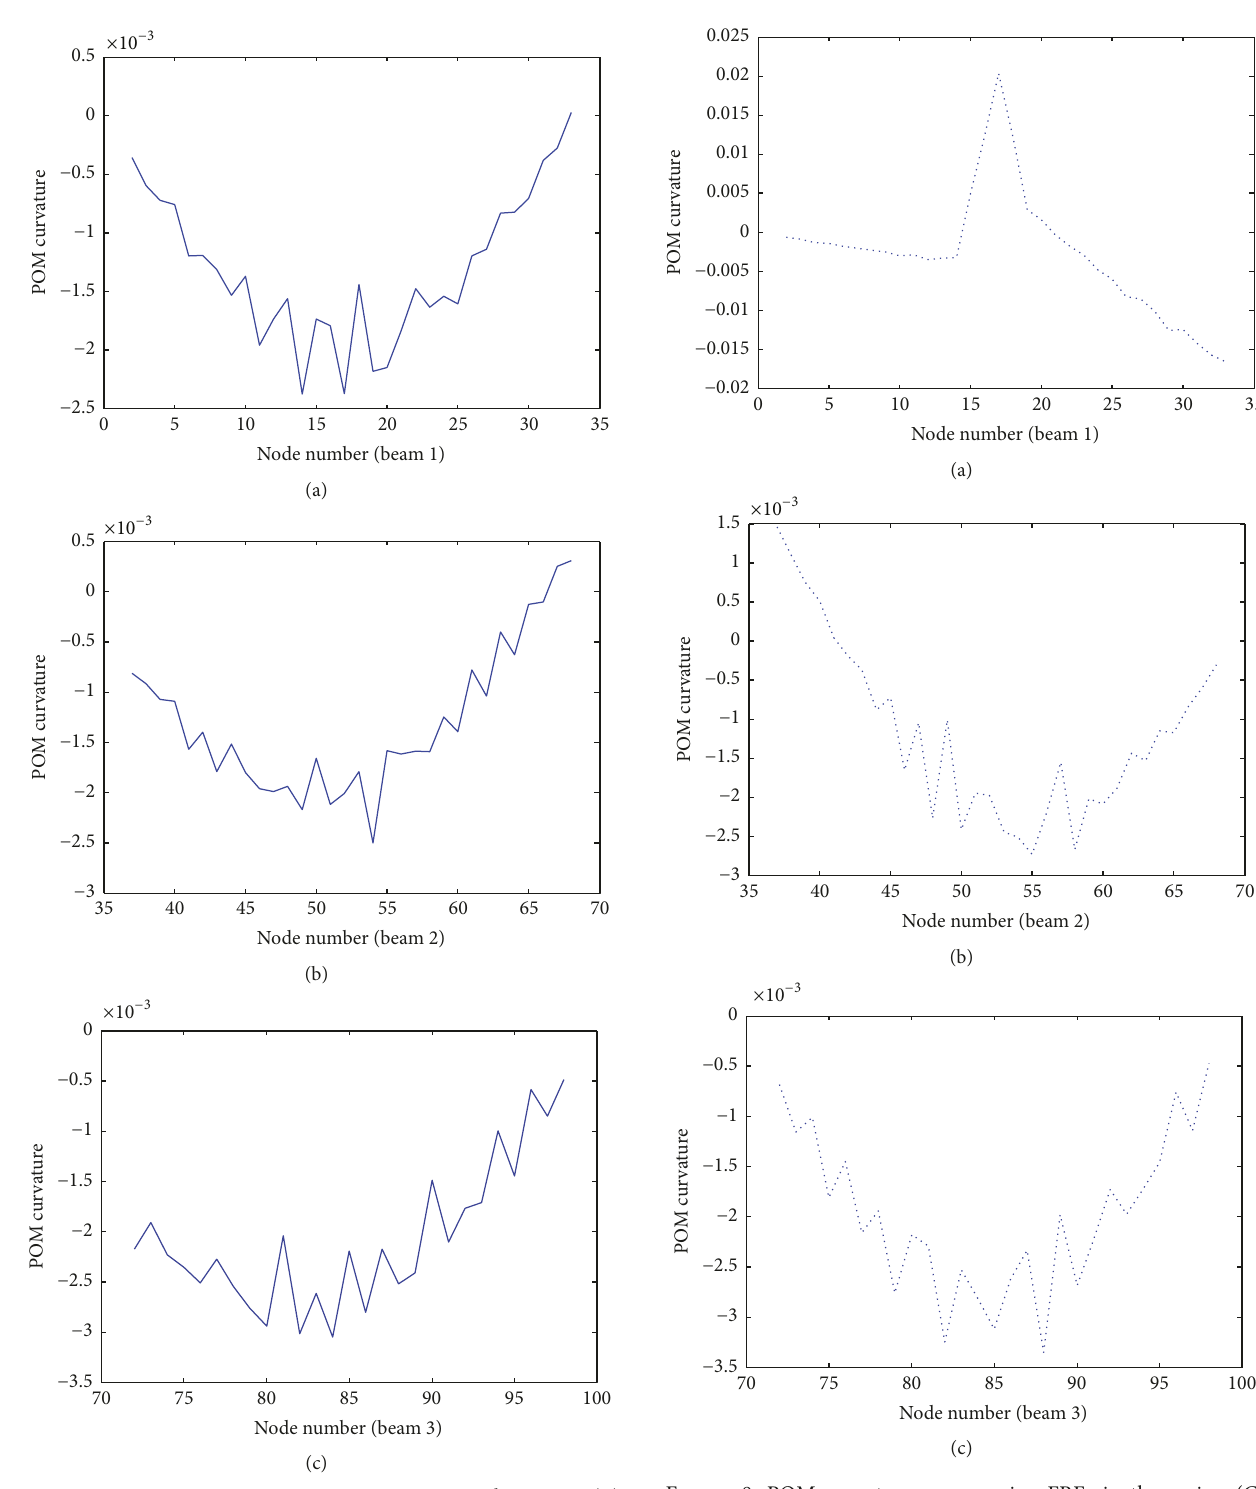
Figure 7: POM curvature curves using FRFs in the region (B) containing 1% external noise: (a) beam 1, (b) beam 2, and (c) beam 3.